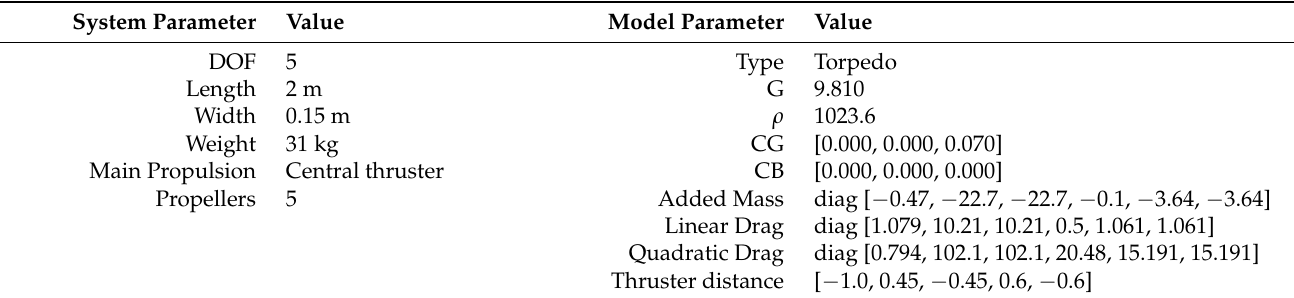
Table 2 gives a general layout of the vehicle characteristics, including the system and dynamic model parameters. Table 2. X300: System Parameters and dynamic model parameters. Thruster distance represents the longitudinal distance of each thruster from the center of body